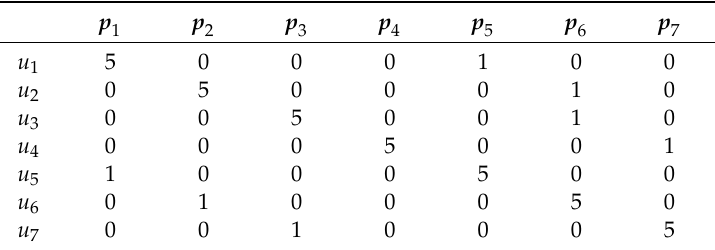
Table 1. A small user-item rating matrix R